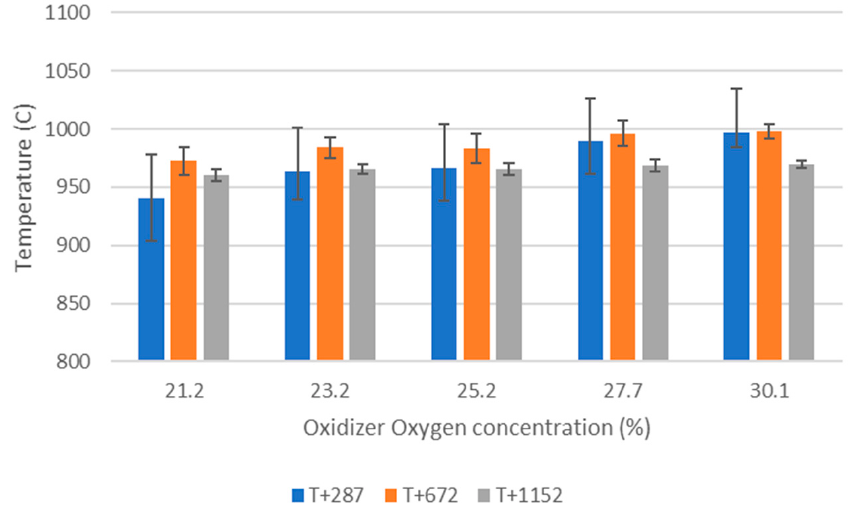
Figure 5. Temperatures and O 2 input concentrations, O 2 /CO 2 input mixes, total oxidizer flow rate in: 160 NL/min (except 30.1, 150 NL/min). “T+number”: see Figure 3 caption.